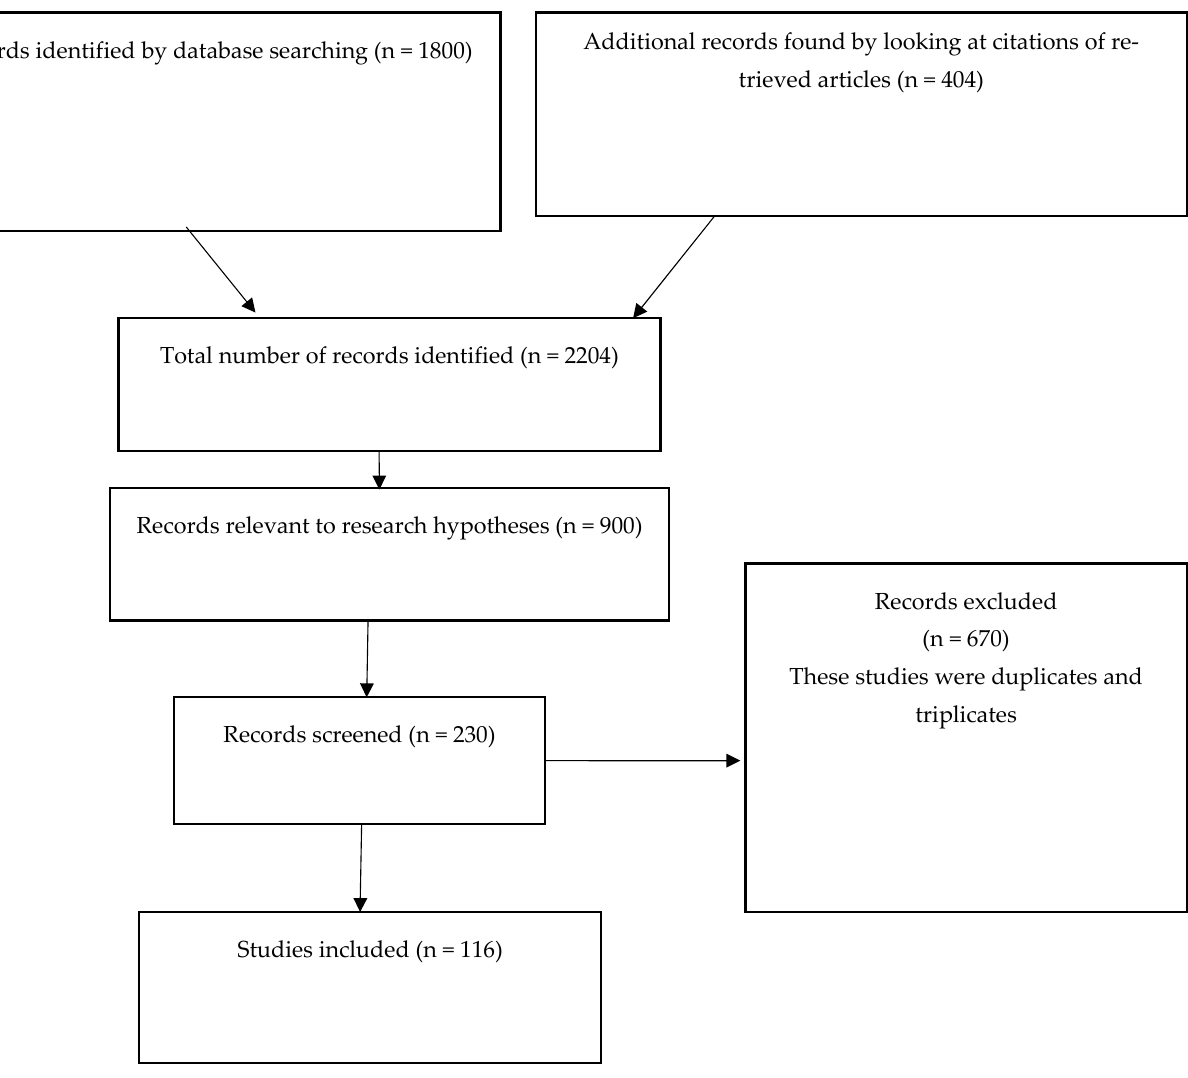
Figure 1. PRISMA flow diagram.